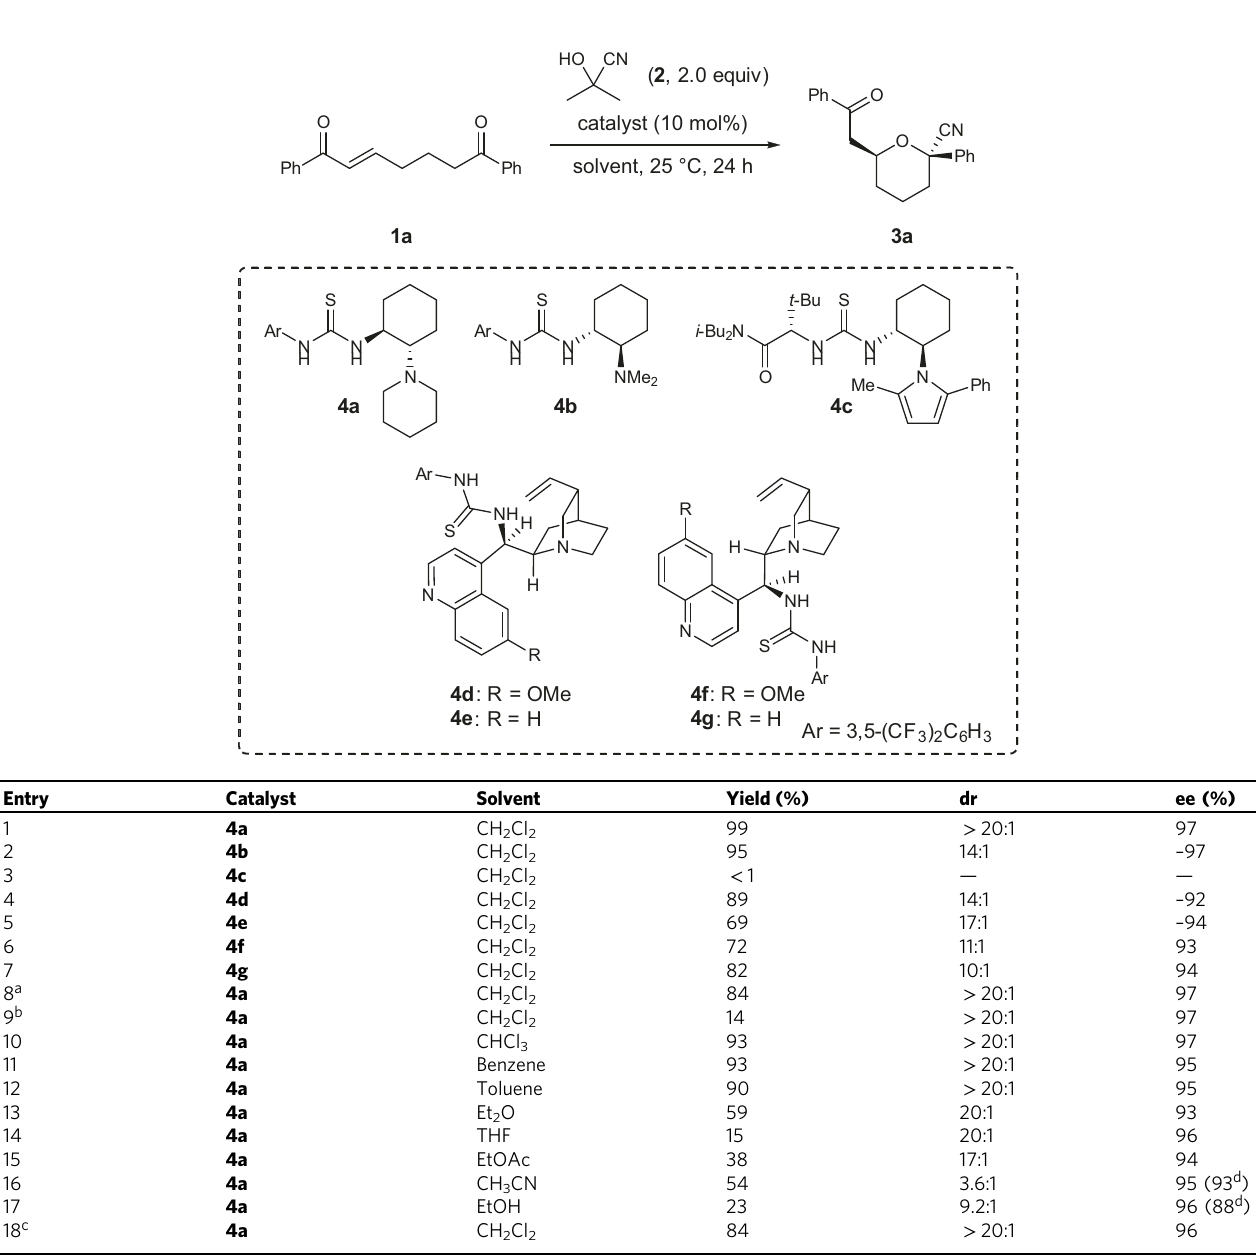
Table 1 Optimization of reaction